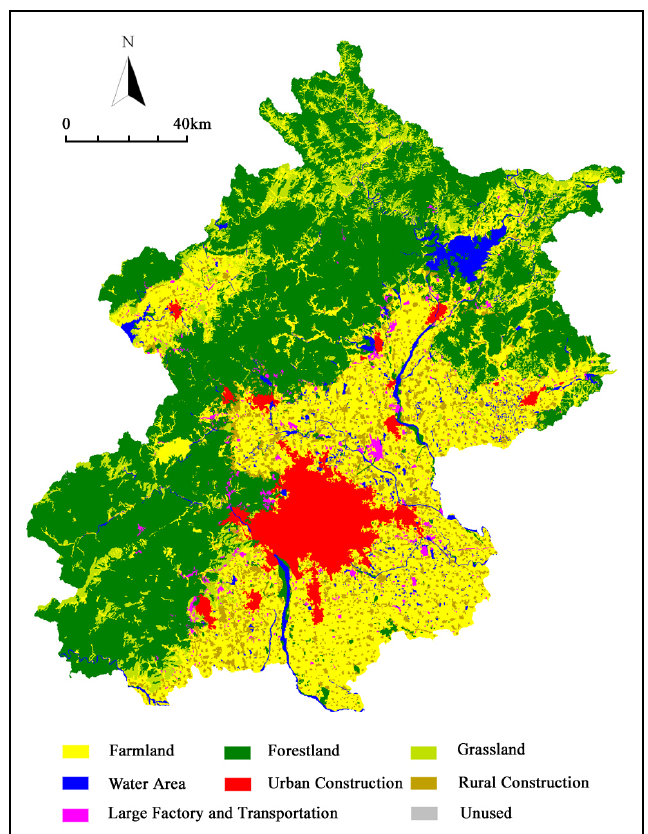
Figure 4. Beijing Land Use Map in 2000.